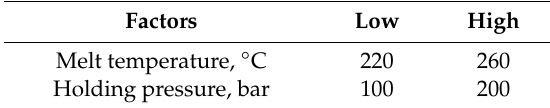
Table 1. Investigated factors for the overmolding of the T-joint